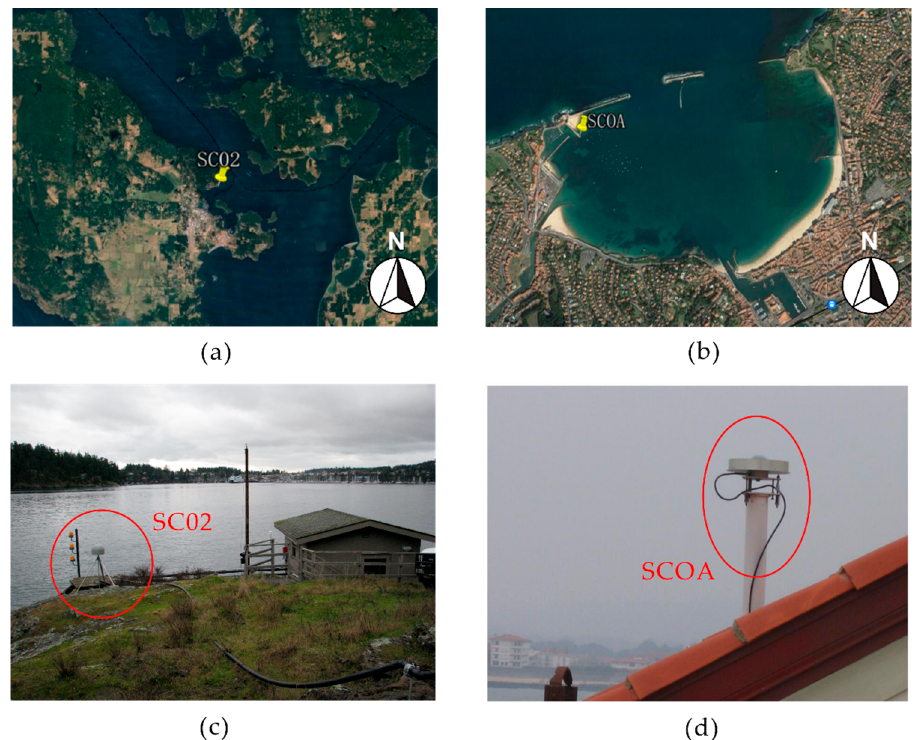
Figure 2. Photographs of the two GNSS reference station SC02 and SCOA: ( a , b ) the aerial view [ 36 ] ; ( c , d ) the surrounding environment. These images are obtained from https://www.unavco.org/instrumentation/networks/status/nota/overview/SC02 (accessed on 18 August 2022) and https://www.sonel.org/ (accessed on 18 August 2022), respectively.